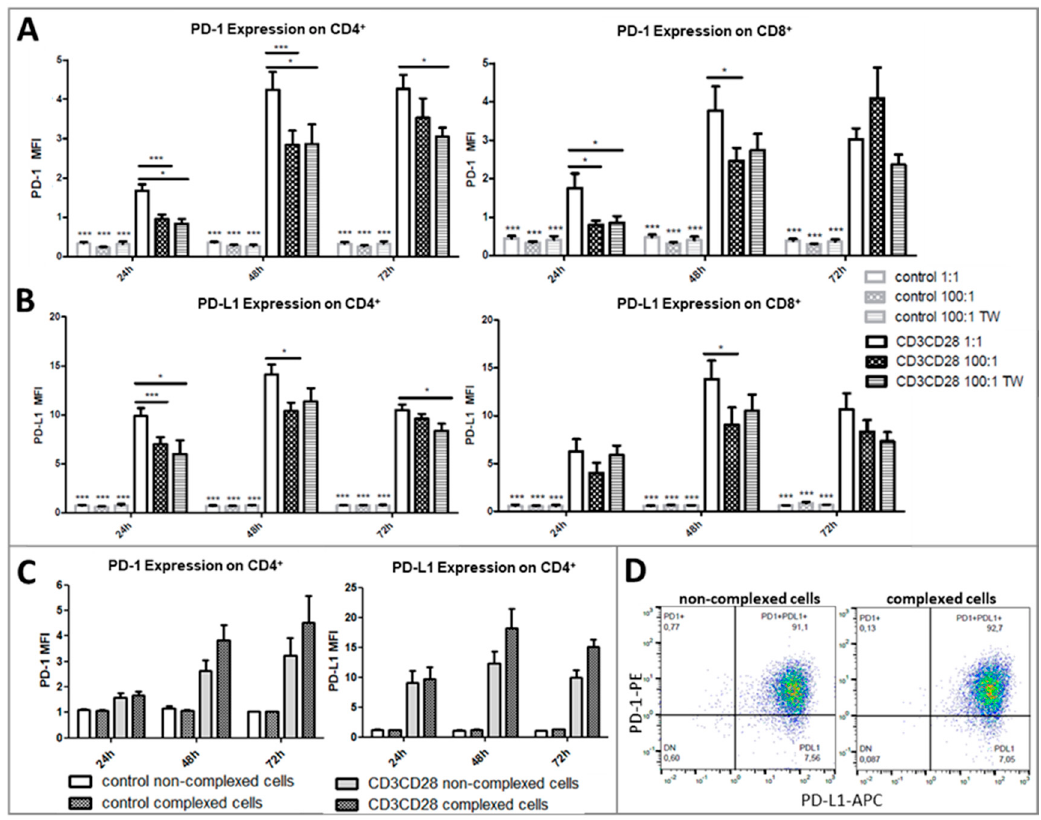
Figure 3. Flow cytometric analysis of the PD-1 and PD-L1 expression levels on CD4+ or CD8+ T cells after 24, 48, and 72 h of culture. Cells were left untreated or stimulated with anti-CD3 and anti-CD28 antibody and cultured in a PLT:PBMC ratio of 1:1, 100:1 (direct contact) or 100:1 in Transwell Assays (TW). ( A , B ) PD-1 and PD-L1 expression intensity (MFI) of CD4+ or CD8+ T cells. Bars show mean + SEM of results from 20 healthy donors. ( C ) PD-1 and PD-L1 expression intensity of complexed or non- complexed CD4+ T cells from stimulated or unstimulated cultures. Bars show mean + SEM of results from 6 healthy donors. * p ≤ 0.05; *** p ≤ 0.001; 1-way Anova with Tukey’s multiple comparisons test. ( D ) Flow cytometric analysis of PD-1 and PD-L1 on complexed and non-complexed CD4+ T cells of one representative sample.